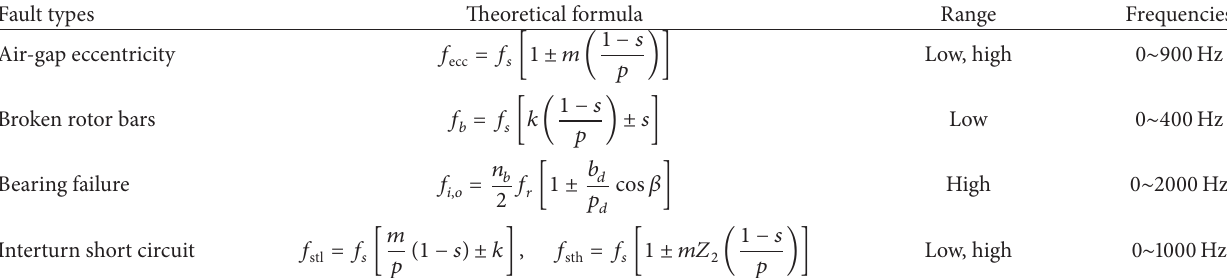
Figure 2: Schematic diagram of fault diagnosis. Table 1: Range of sideband frequencies in terms of faulty